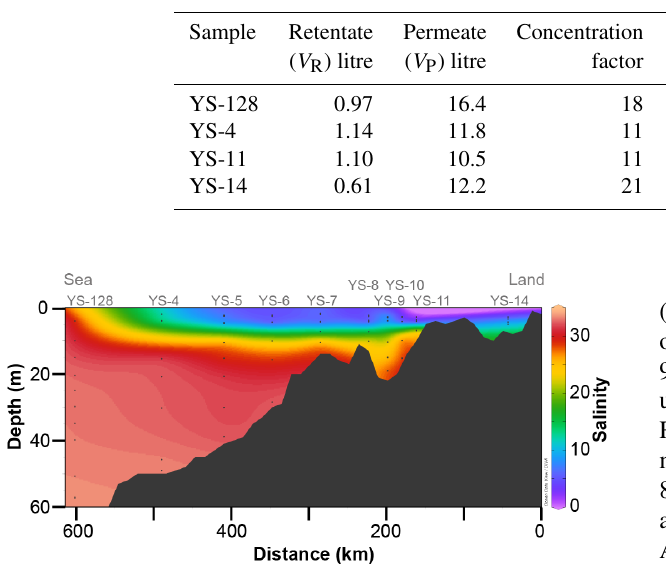
Table 2. Cross-flow ultrafiltration details.